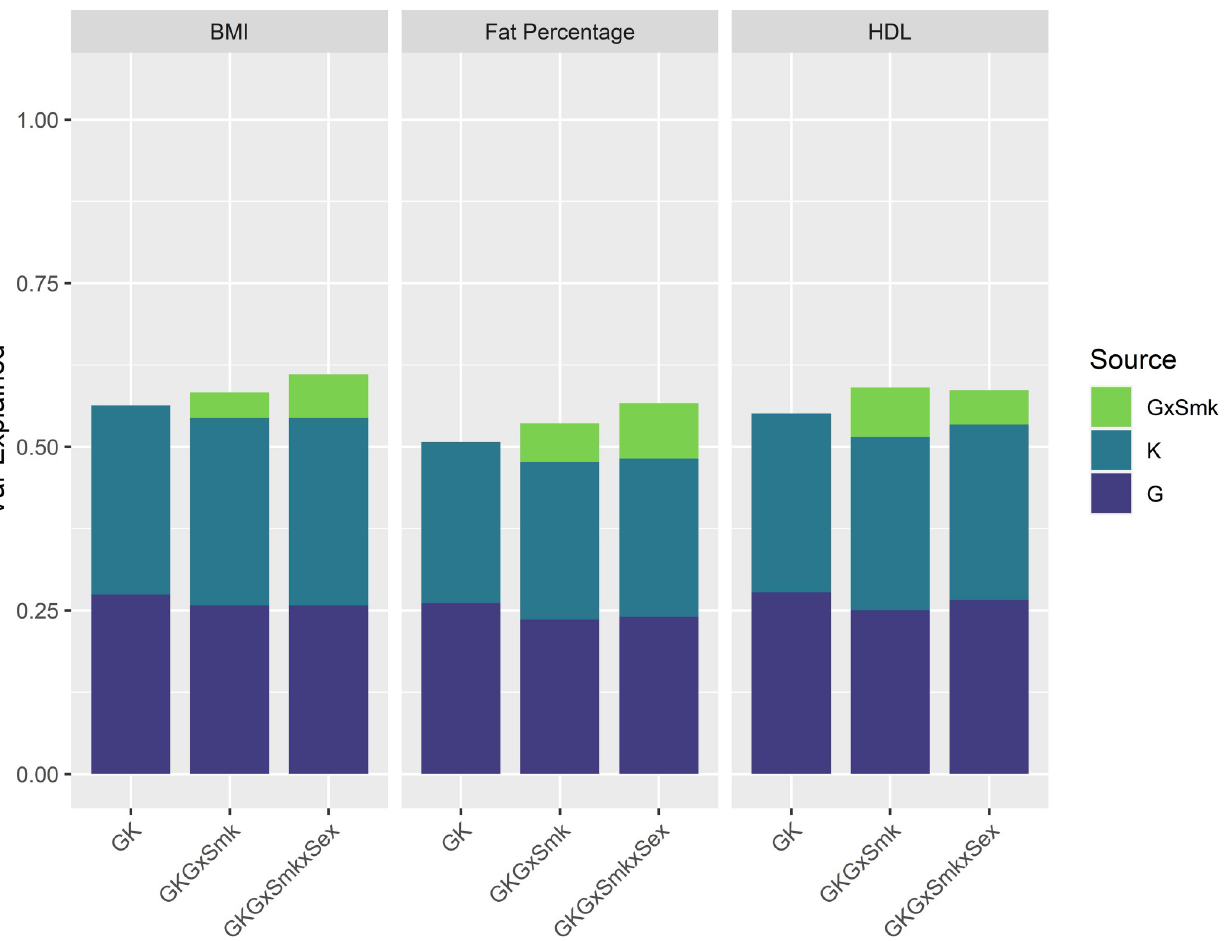
Fig 2. Proportion of trait variation explained by genetic and interaction sources in GS18K. Proportion of BMI, fat percentage, and HDL variance (y- axis) explained by each of the genetic and interaction sources in the corresponding models (x-axis). G: Genomic, K: Kinship, GxSmk: Genome-by-Smoking, GxSmkxSex: